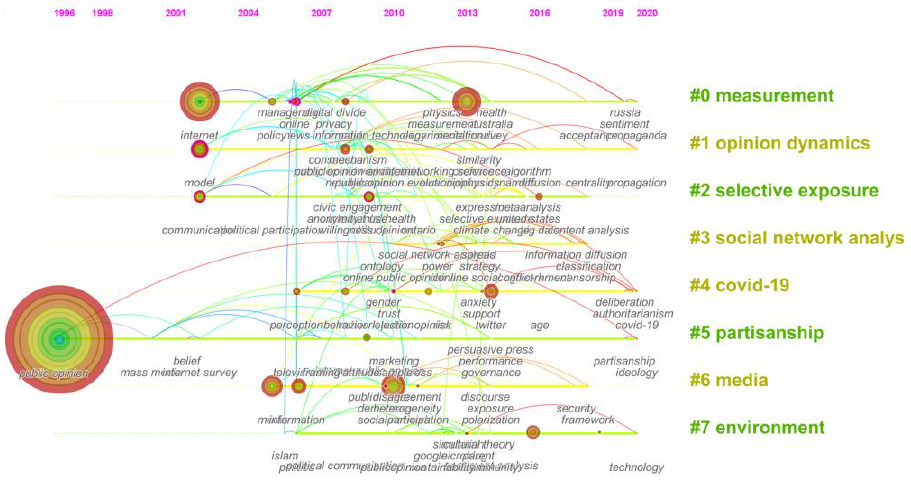
Figure 14. The keywords timeline view of NPO studies.